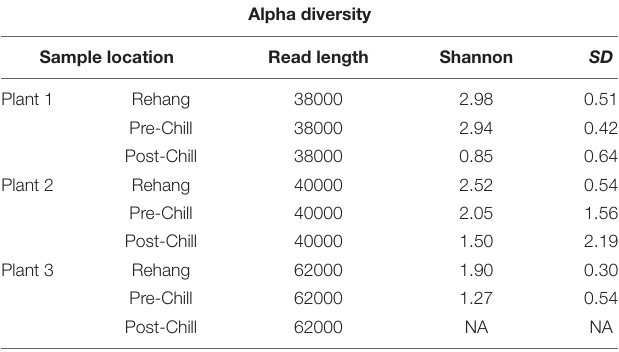
TABLE 5 | Summary of Illumina Mi-Seq read lengths and QIIME Shannon Diversity.